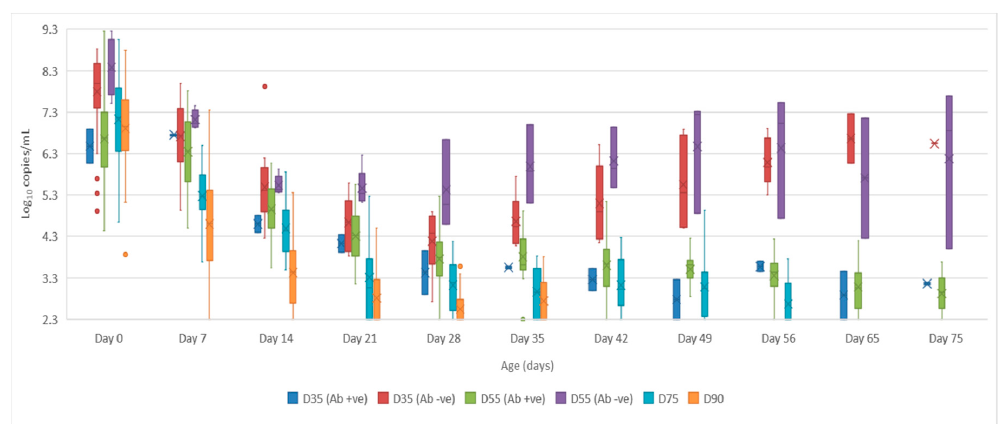
Figure 2. Box and whisker plot summarising the quantity of Bungowannah virus detected in serum between 0 to 75 days of age following in utero infection at one of four stages of gestation (x = mean; — = median; the whiskers extend up from the top of the box to the largest data element that is less than or equal to 1.5 times the interquartile range (IQR) and down from the bottom of the box to the smallest data element that is larger than 1.5 times the IQR. Values outside this range are considered outliers and are represented by dots).